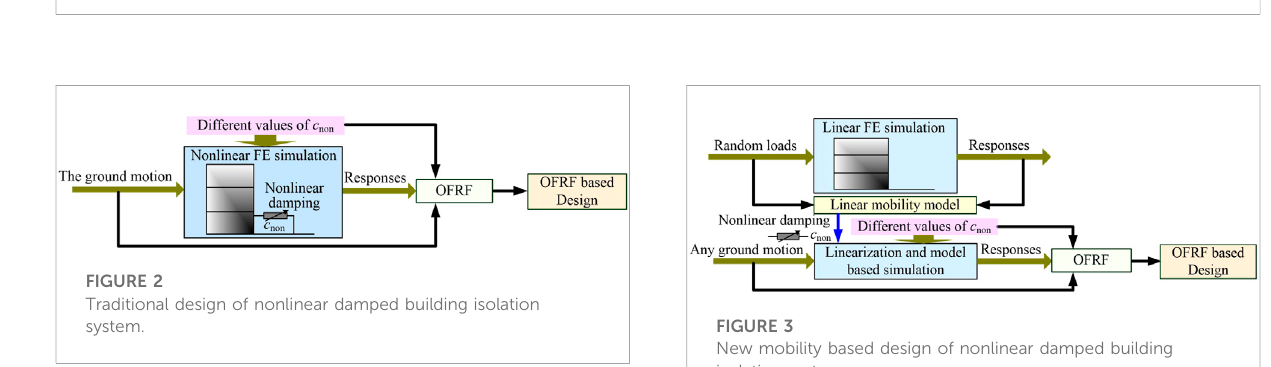
FIGURE 1 4-DoF building system. (A) The linear 4-DoF building, (B) The 4-DoF building with nonlinear damping isolator.